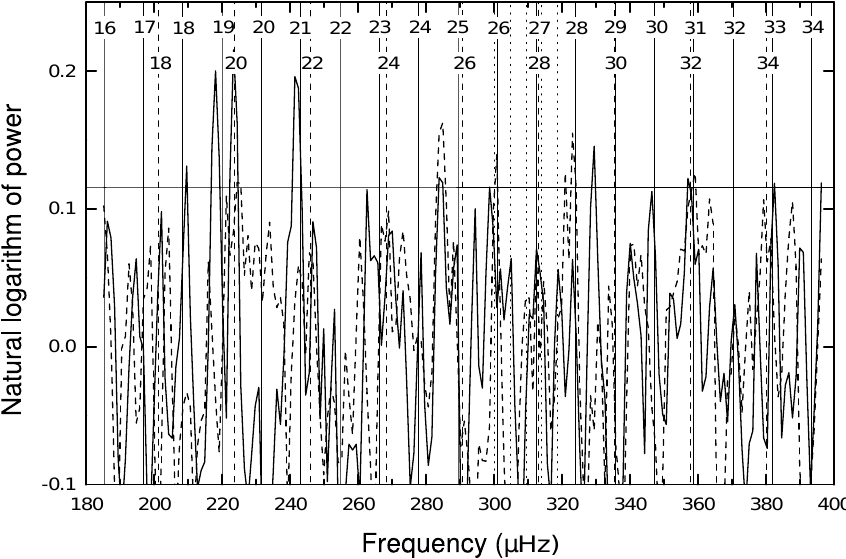
Fig. 1. Product spectra of ground pressure (continuous line) and seismic (dashed line) oscillations in the 42 − 90-min period subrange, obtained from all the available measurements by microbarograph and seismograph at St.Petersburg (60 ◦ N, 30 ◦ E). The horizontal line represents the 10% probability level. The vertical lines correspond to the frequencies of harmonics of the solar (solid lines) and lunar (dashed lines) day and of the 0 S 2 mode components (dotted lines). Numbers at the vertical lines are the harmonics.